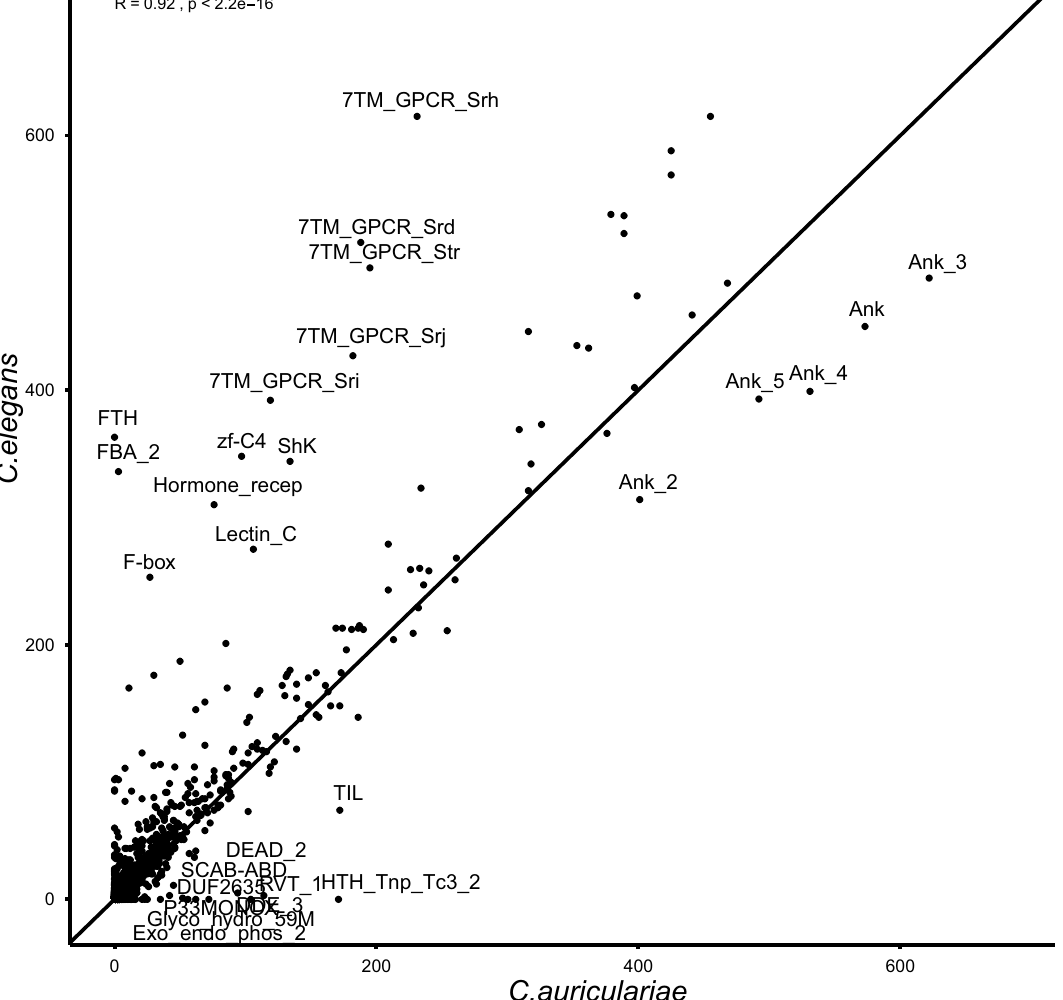
For a genome-wide phylogenetic analysis, amino acid sequences of 96 single-copy orthologous in 37 species were aligned using MAFFT v7.221 41 with auto options. Poorly aligned regions were removed using Gblocks v0.91b 66 with the parameters (-t = p, -b4 = 10, -b5 = n, -b6 = y, -s = y, -p = y, -e = -gb). The alignments were con- catenated and used to generate a maximum-likehood tree using RAxML v8.0.26 67 . For the RAxML analysis, alignments were partitioned by gene with the PROTGAMMAAUTO model (the best-fitting model for each gene) used for all partitions. The topological robustness was assessed with 100 replicates of fast bootstrapping. Resulting phylogenetic tree was visualized in FigTree v1.4.4 68 .